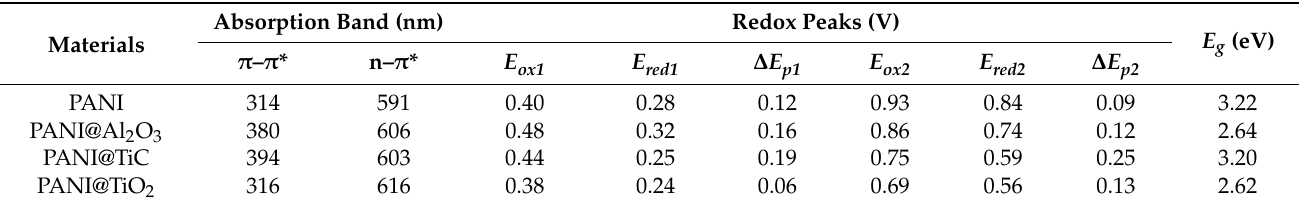
Table 2. Absorption band, redox peak, and bandgap energy ( E g ) of the synthesized materials.